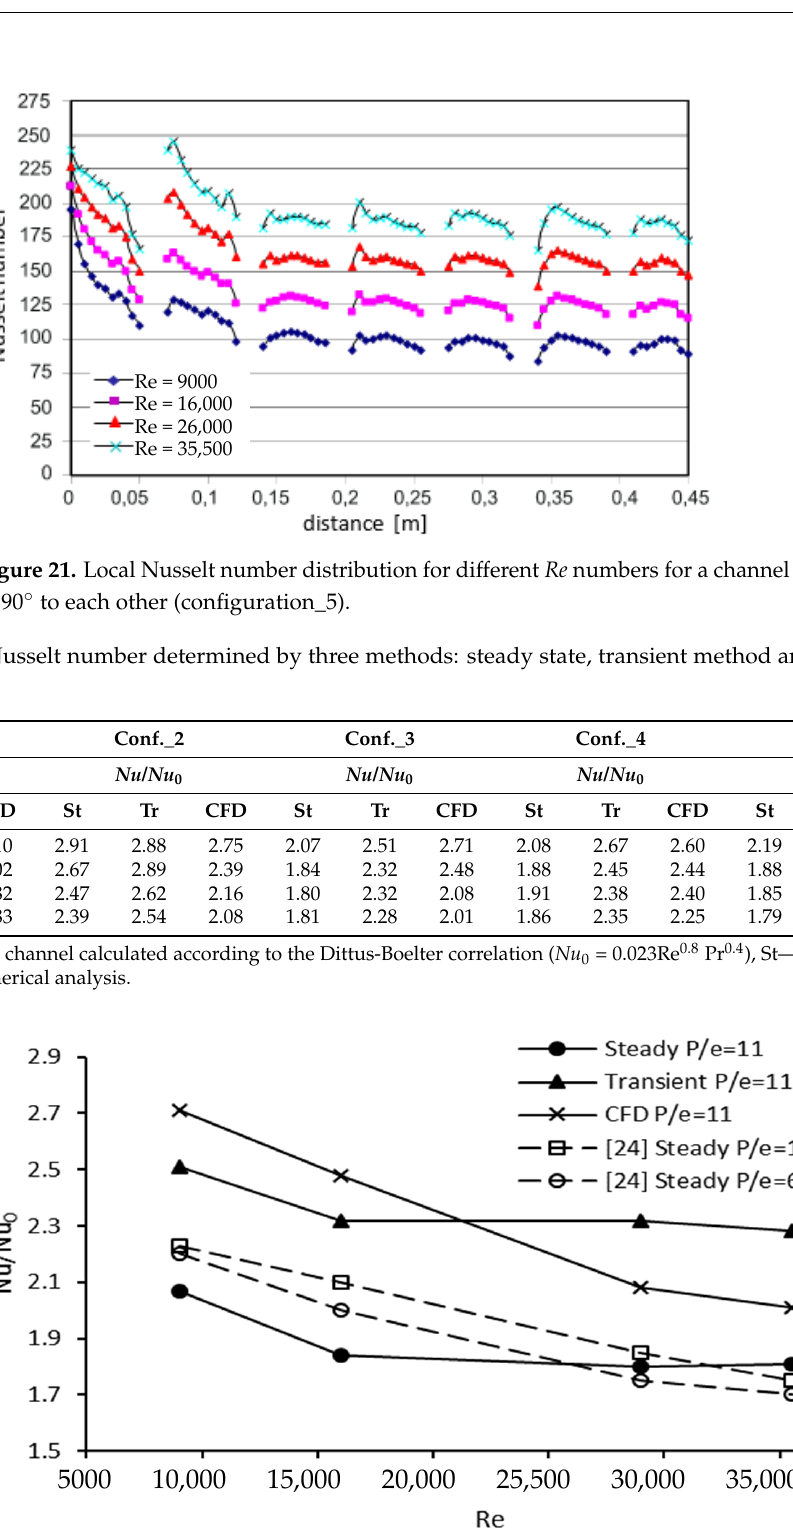
Figure 22. Experimental and normalized Nusselt number versus the Reynolds number obtained by the authors and Tanda and Abram [25] for Configuration_3.